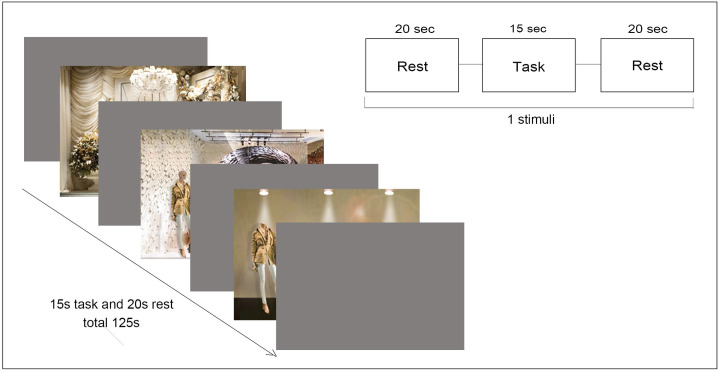
Experiment paradigm.